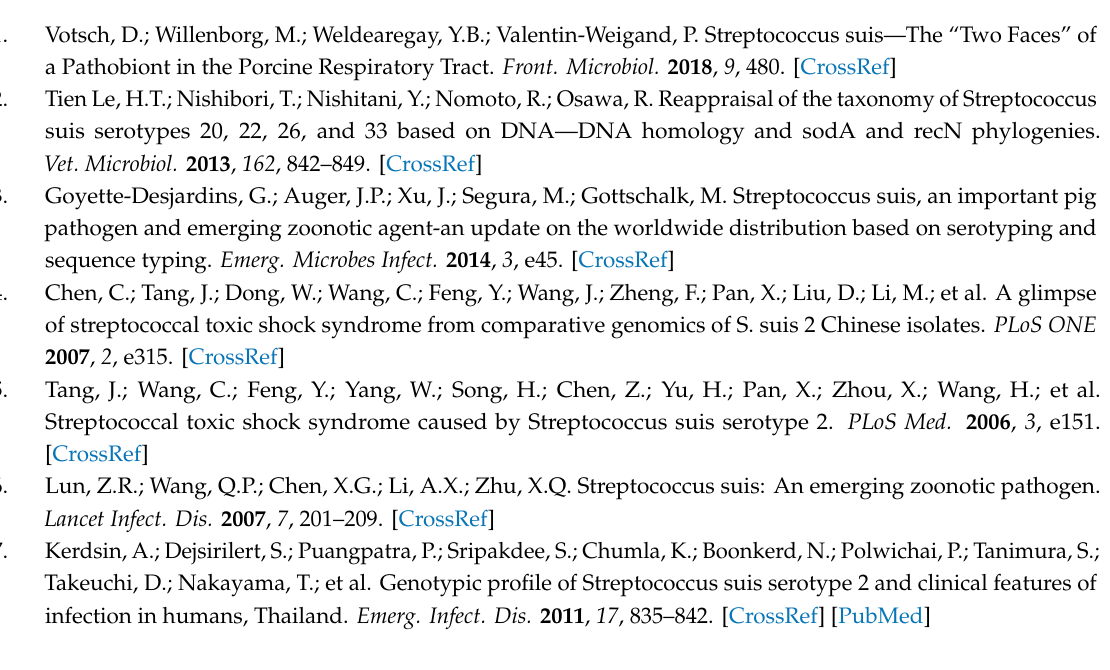
Figure S1: Homology comparison between HP1717 and di ff erent bacterial homologous proteins; Figure S2: Cell surface localization confirmed by flow cytometry; Figure S3: Zymogram analysis. SDS-PAGE were stained by Coomassie Brilliant Blue (left) and Methylene Blue (right)